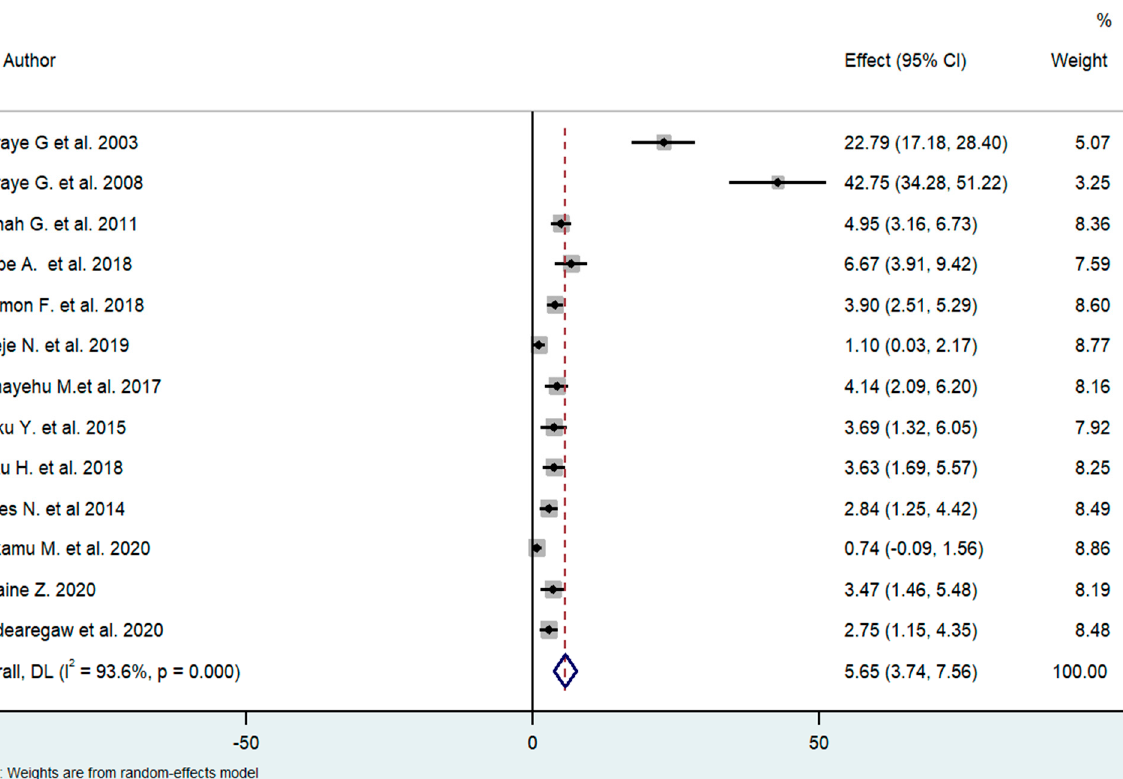
Figure 2. Forest plot of the proportion of PCP among HIV patients in Ethiopia (2003–2020, I 2 = 93.6%, p < 0.01); Q statistics (242.2185, p < 0.0001); and test of overall effect (0, z = 5.797, p = 0.000). High heterogeneity is suggested in the effect size. To identify the source of heterogeneity, the authors conducted a subgroup analysis [18,21,26–36].